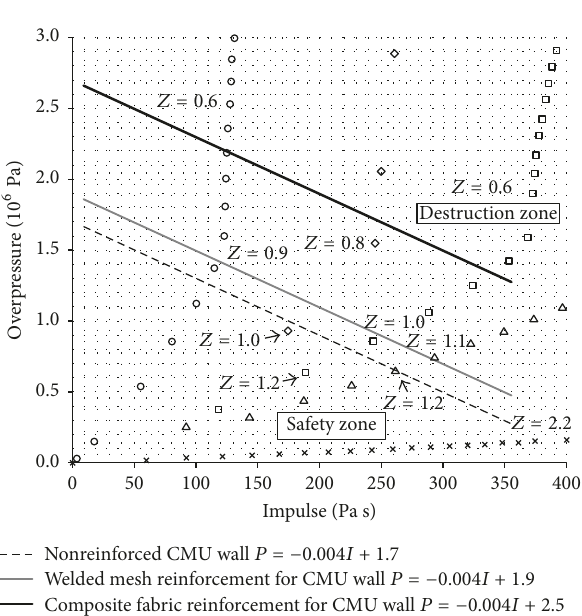
Figure 16: Resistance of CMU for different system of reinforcement.